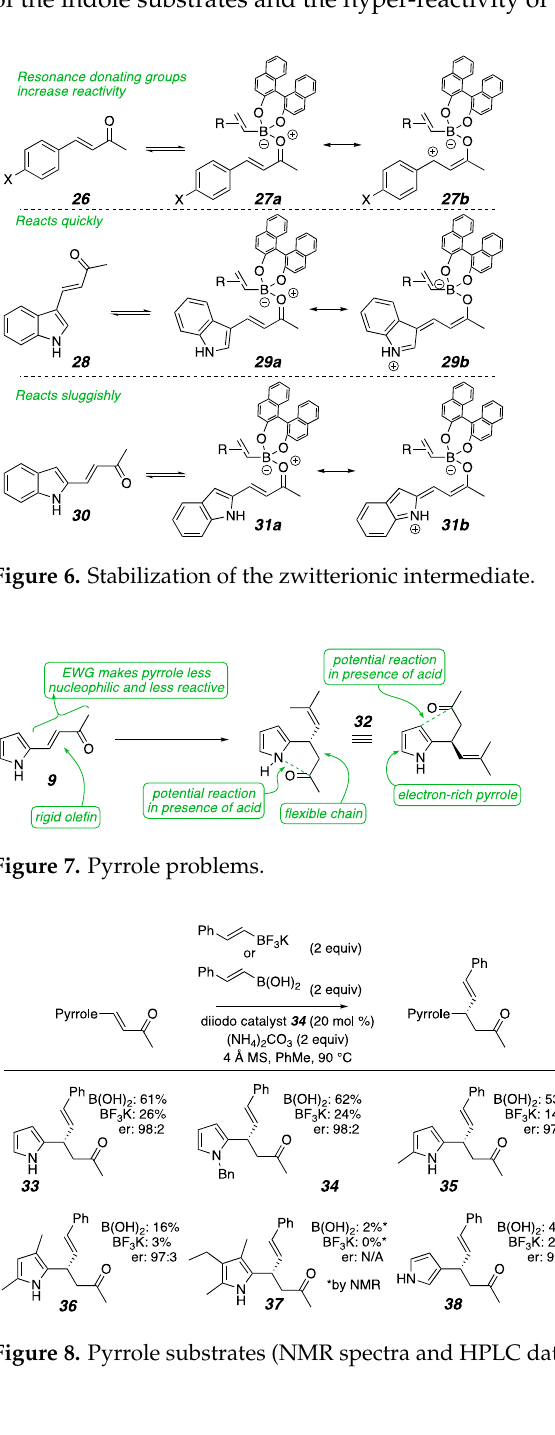
Figure 6. Stabilization of the zwitterionic intermediate.